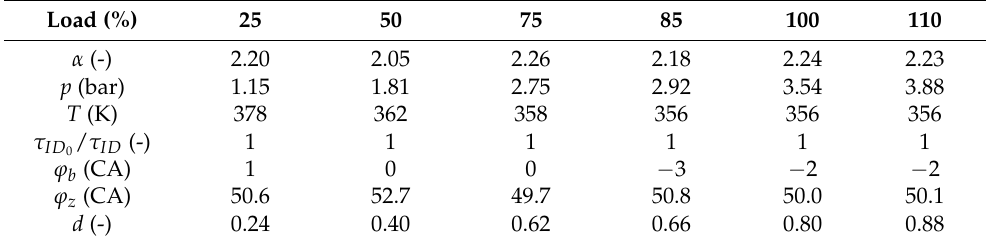
Table 8. The Wiebe parameters according to the WA model in gas fuel mode. Load (%)